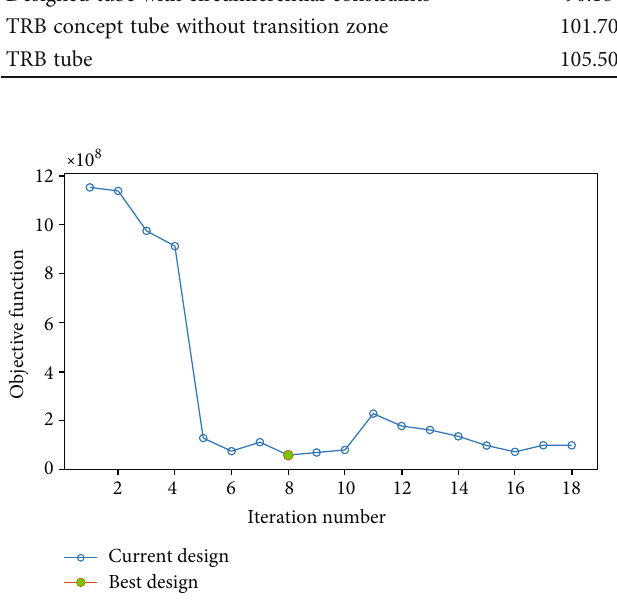
Figure 22: Objective function vs. number of iterations.